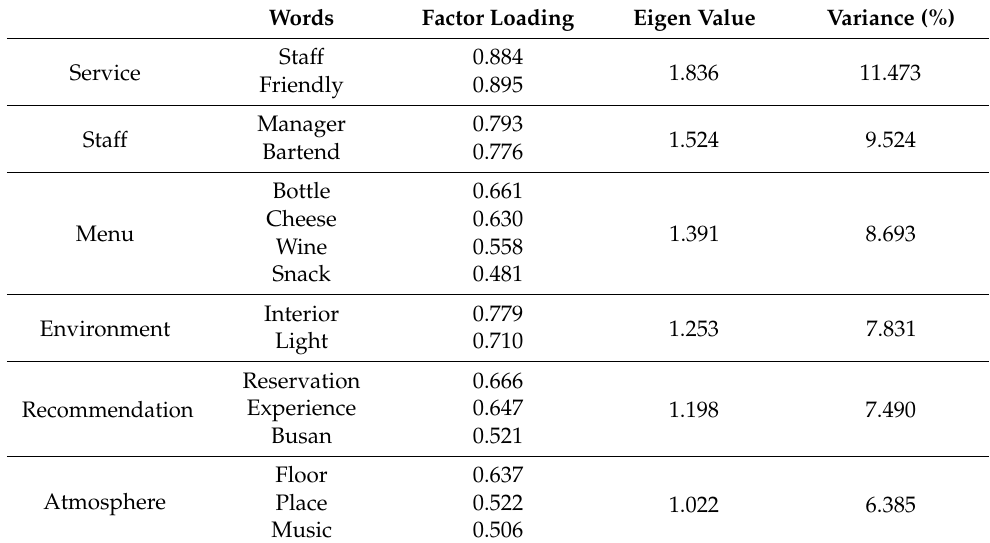
Table 5. Result of the factor analysis.